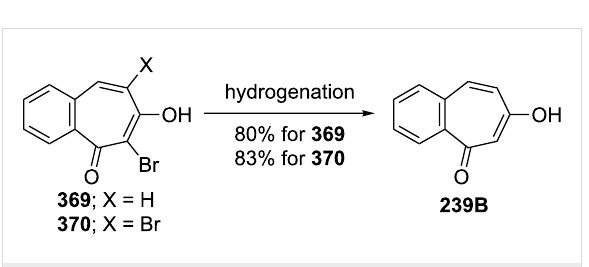
Scheme 71: Hydrogenation of bromobenzotropolones 369 and 370